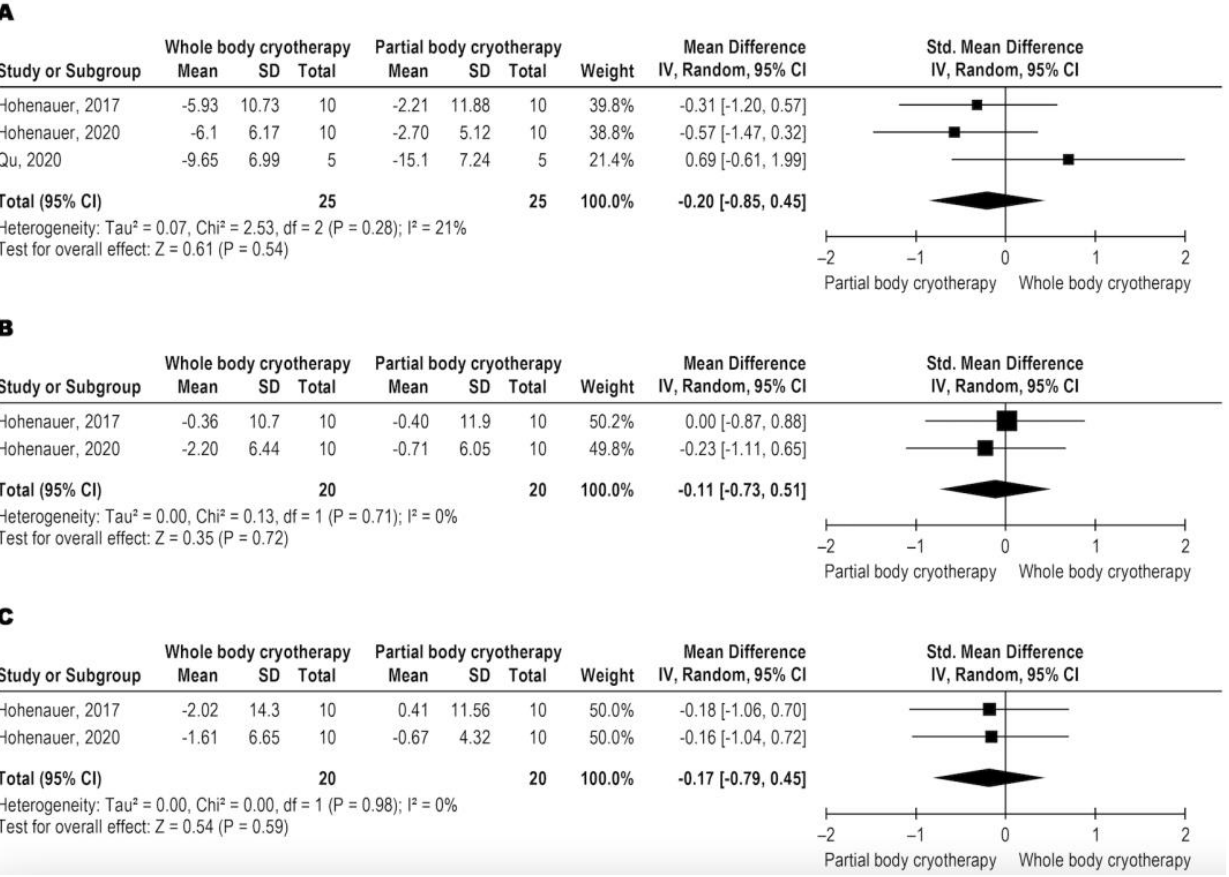
Figure 3. Metanalysis comparison between WBC and PBC for VJP ( A ) immediately-post interven- tion [5,12,16], ( B ) 24 h after intervention [5,16], and ( C ) 48 h after intervention [5,16].